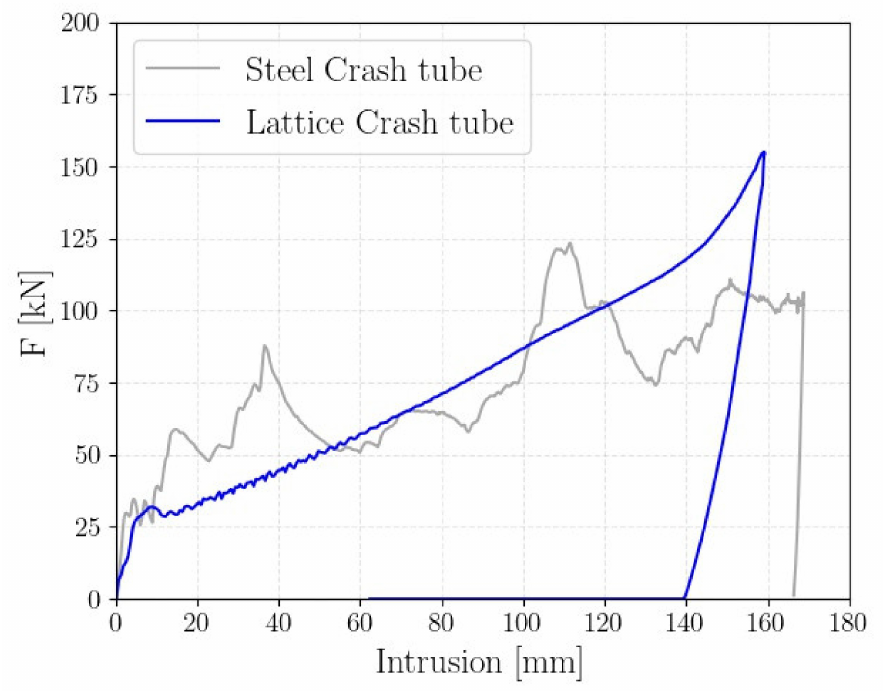
Figure 14. Comparison of the force–displacement curve between the reference crash tube and the lattice-based crash